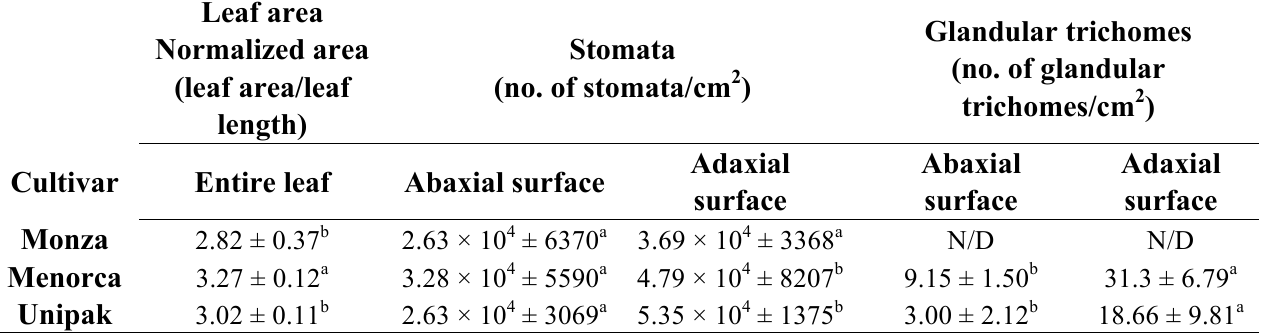
Table 4. Morphological features of spinach cultivars d .